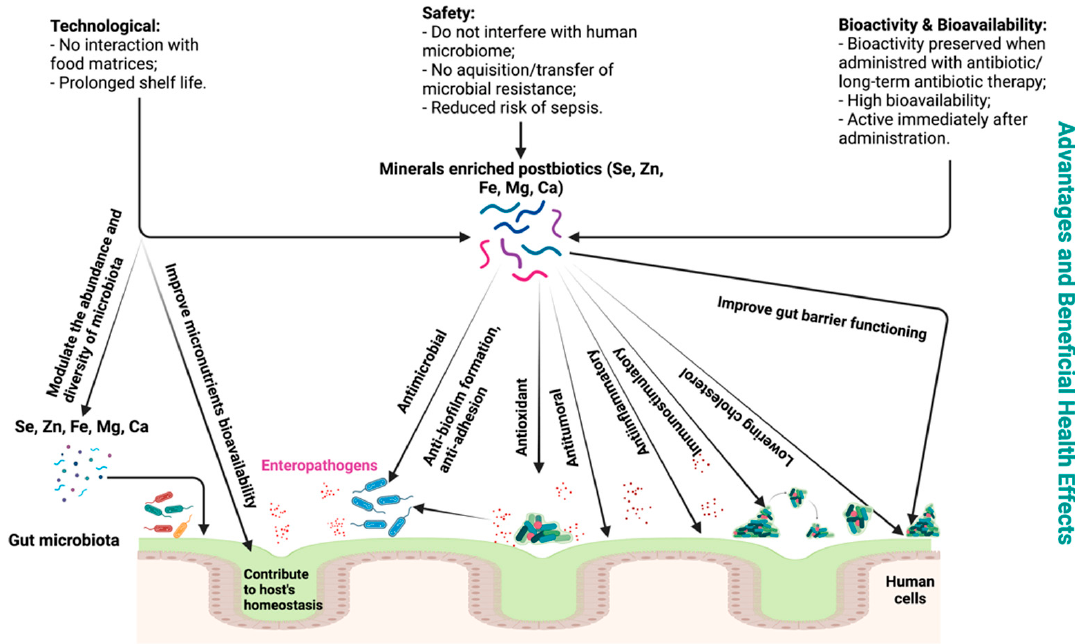
Figure 2. Mineral-enriched postbiotic advantages and beneficial health effects.